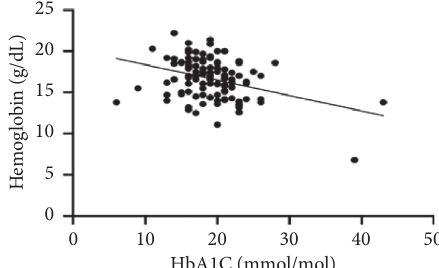
Figure 3: Relation between hemoglobin and HbA1C ( r � 0.127; p < 0 . 0001).